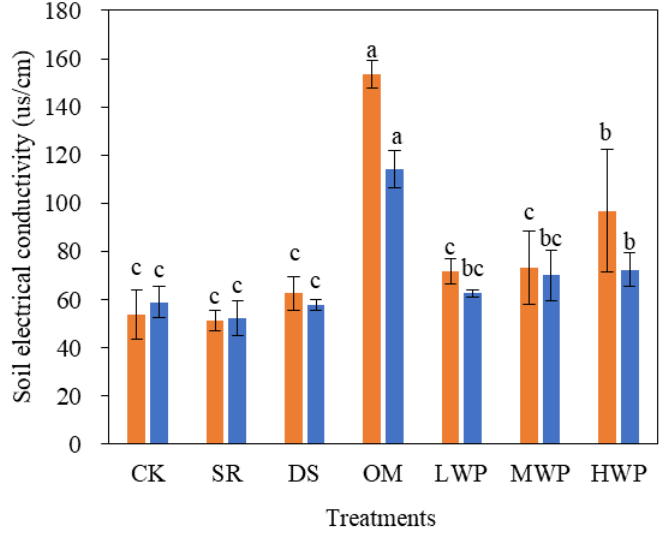
Figure 5. Changes in soil electrical conductivity (EC) under different treatments. Different lowercase letters in the box denote significant differences between different treatments of the same year at p < 0.05, respectively.